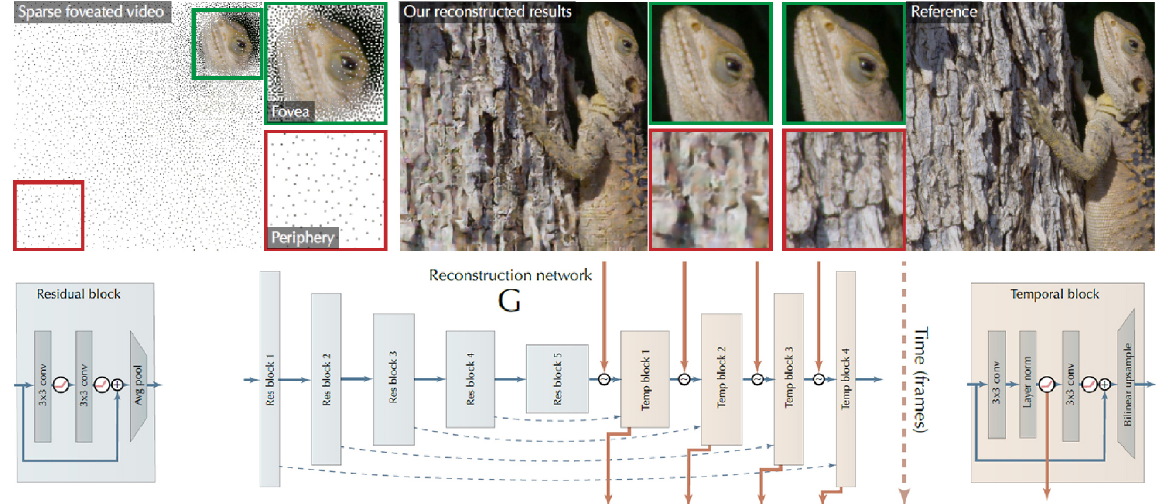
Fig. 12 Neural reconstruction for foveated rendering and video compression proposed by Kaplanyan et al. [38]. The authors reconstructed the foveated video through a generative adversarial neural network from the sparse foveated video frames with 10% of pixels (top left). This method reconstructed the video compressed by more than 14 × of the original video, and the reconstructed result (top middle) had no significant reduction in perceptual quality compared with the reference (top right). The recurrent video encoder–decoder network architecture is visualized in the bottom. Reproduced with permission from Ref. [38], c (cid:13) Owner/Author